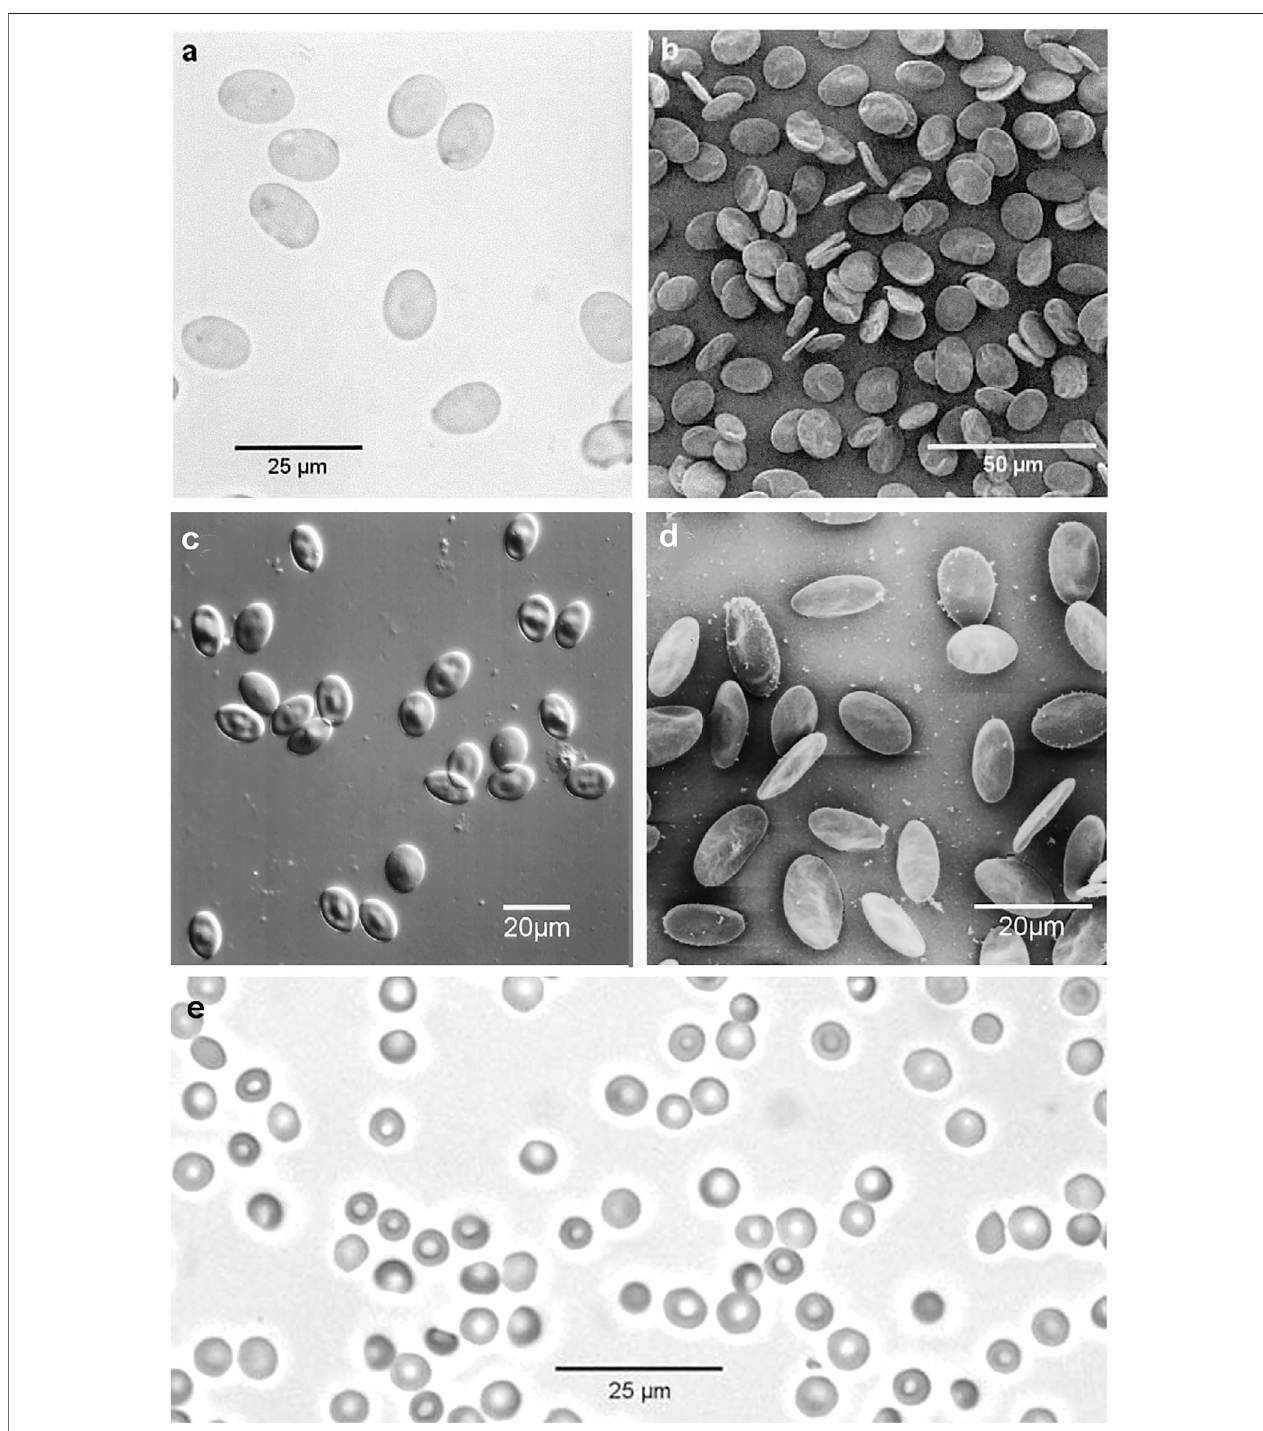
FIGURE 1 | Reptiles, birds and monotremes: (A) Green Sea Turtle ( Chelonia mydas ) RBCs, bright fi eld optical micrograph (Nikon Eclipse E800 Plan Apo ×40 0.95NA objective); (B) Green Sea Turtle RBCs, secondary electron SEM image (Jeol JSM-6300f); (C) Little Penguin ( Eudyptula minor ) RBCs, DIC optical micrograph (Nikon Eclipse E800 Plan Apo ×40 0.95NA objective); (D) Little Penguin RBCs, secondary electron SEM image (Jeol JSM-6300f); (E) Platypus ( Ornithorhynchus anatinus )RBCs,bright fi eldopticalmicrograph.(NikonEclipseE800PlanApo×400.95NAobjective).Theoriginalimageswerepublishedby(Benga , 1994;Benga, 2003; Benga et al., 2015).